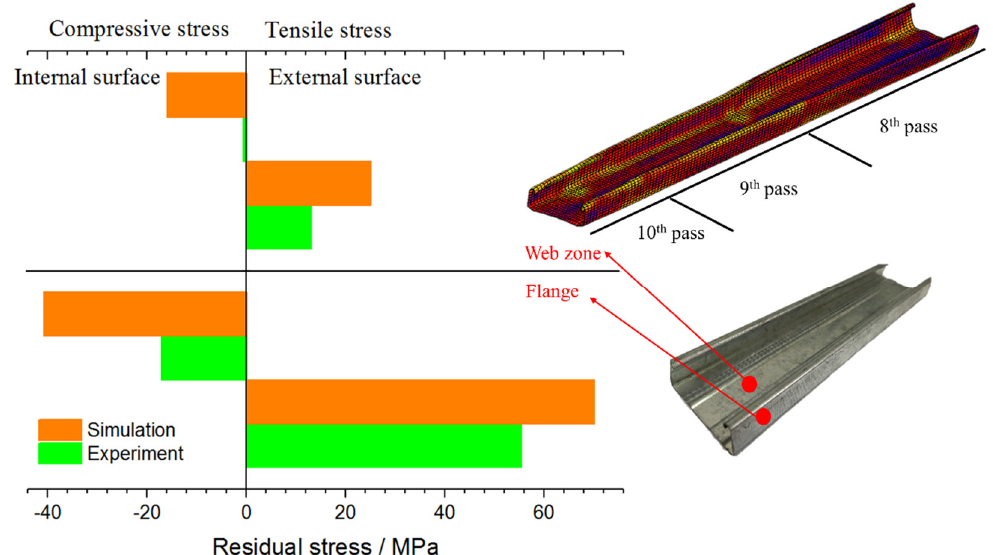
Figure 8. Comparison of the numerical and the experimental residual stress.